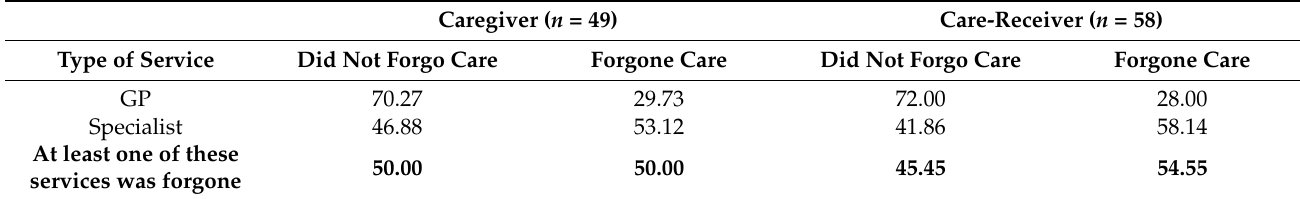
Table 3. Percentage of caregivers who had to forgo care for needed medical services.